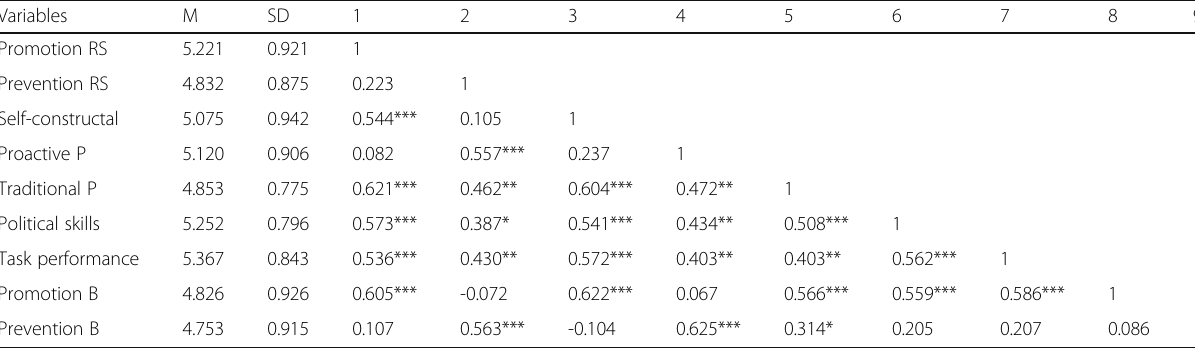
Table 1 Means, standard deviations, and correlations